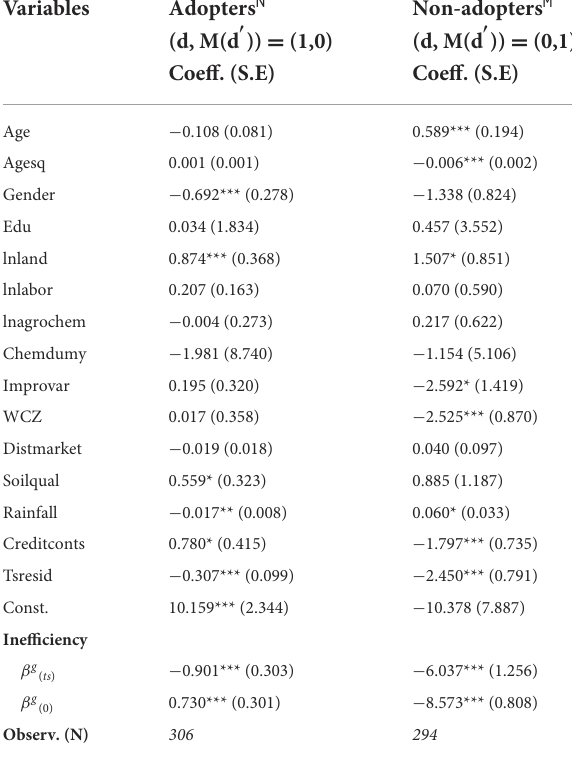
TABLE 4 Adoption with mediation—(weighted nonlinear least-squares)—farm net returns (lnGHC/Ha). Variables Adopters